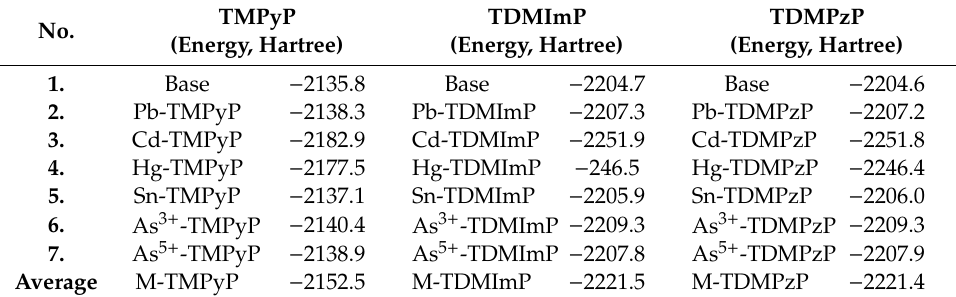
Table 1. Molecular energies of the optimized structures of cationic porphyrin complexes.